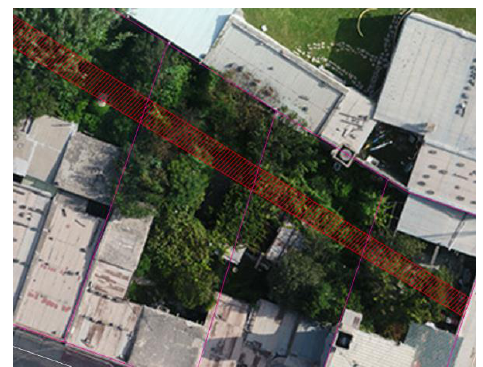
Figure 7. Hatched Area is a Drainage Area badly used by